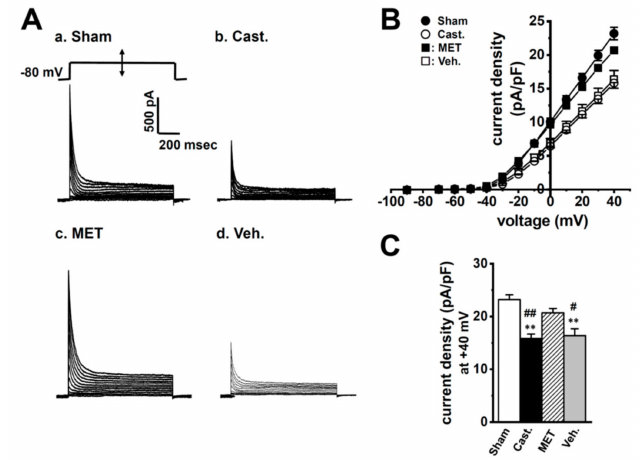
Figure 3. E ff ects of castration on transient outward currents, I A density in rat VDSMCs. ( A ) I A was elicited by a 1000 ms depolarizing-voltage-step between − 70 and + 40 mV from a holding potential ( − 80 mV) with 10 mV increments once every 10 s in the VDSMCs of each group. ( B ) Current density–voltage relationship in each group. ( (cid:8) ) sham-operated ( Sham ) ( n = 15), ( ) castrated ( Cast. ) (cid:35) ( n = 20), ( (cid:4) ) MET-treated ( MET ) ( n = 17), and ( (cid:3) ) vehicle-treated ( Veh. ) ( n = 16). ( C ) Summarized data of current density at + 40 mV in four groups. ** p < 0.01 versus Sham; # , ## : p < 0.05, 0.01 versus MET. Table 1. Electrophysiological parameters in rat VDSMCs of each group—sham-operated ( Sham ), castration ( Cast. ), MET-treated ( MET ), and vehicle-treated ( Veh. ). *, **: p < 0.05, 0.01 versus Sham; # , ## : p < 0.05, 0.01 versus MET. Sham Cast. MET Veh. current amplitude at + 40